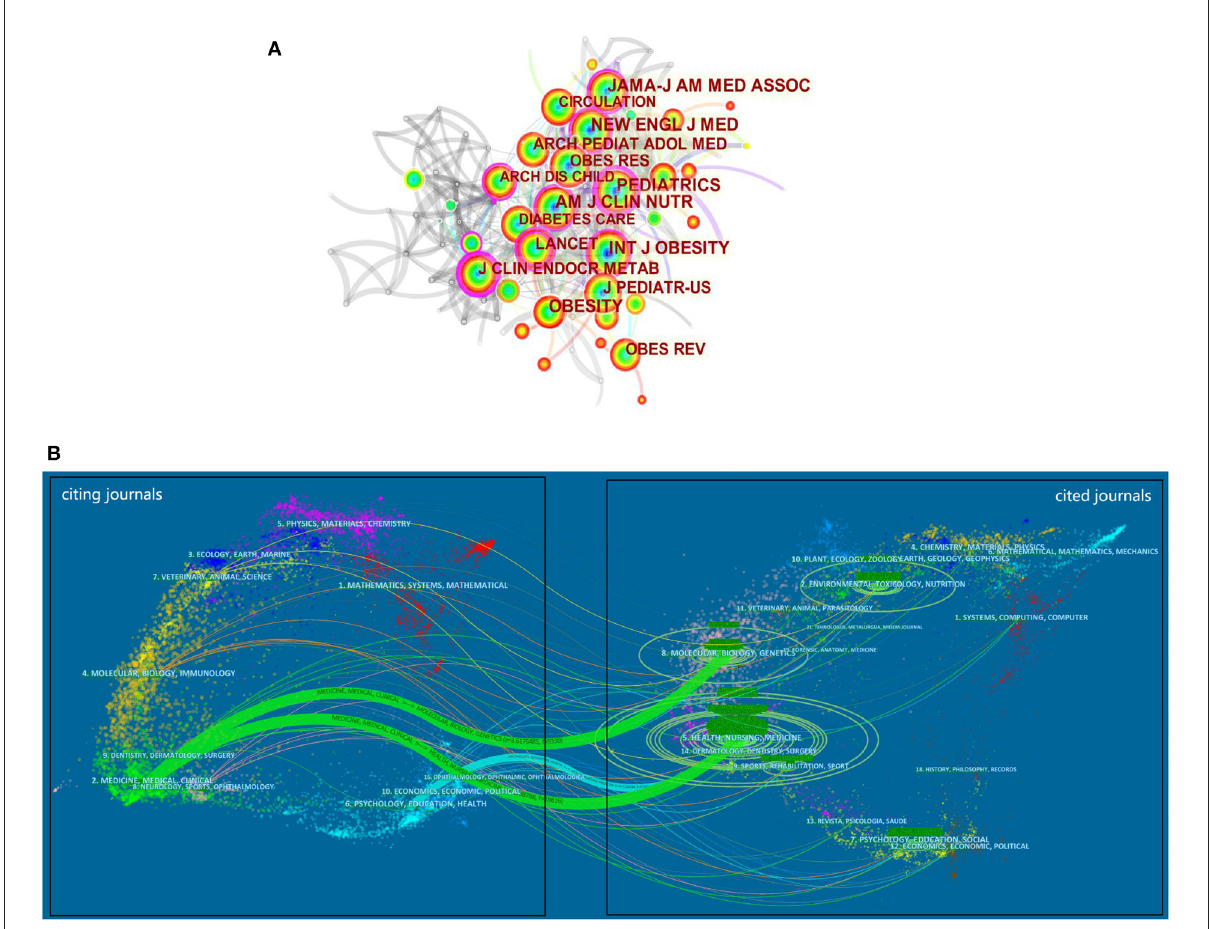
FIGURE5 Co-citation journal network in the research of WLOCA (A) ; A dual-map overlay of journals that published literature in the research of WLOCA (B) .